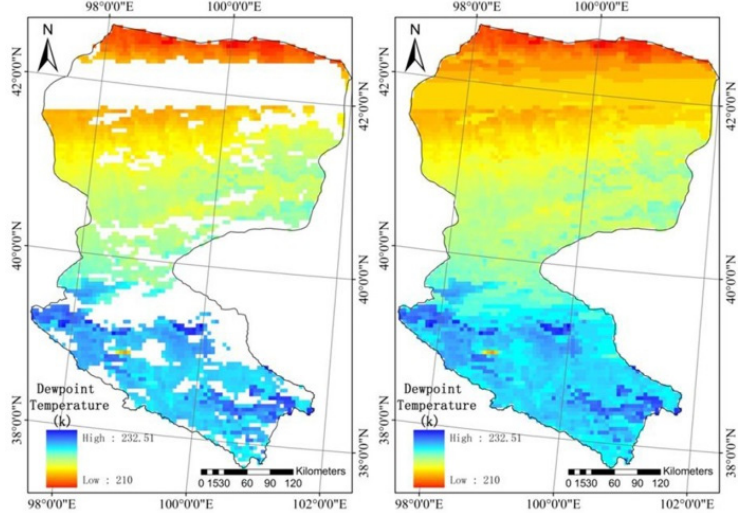
Figure 5. The moisture data for the Heihe river basin at 700 hPa before and after application of the gap-filling process for 2 January 2012.